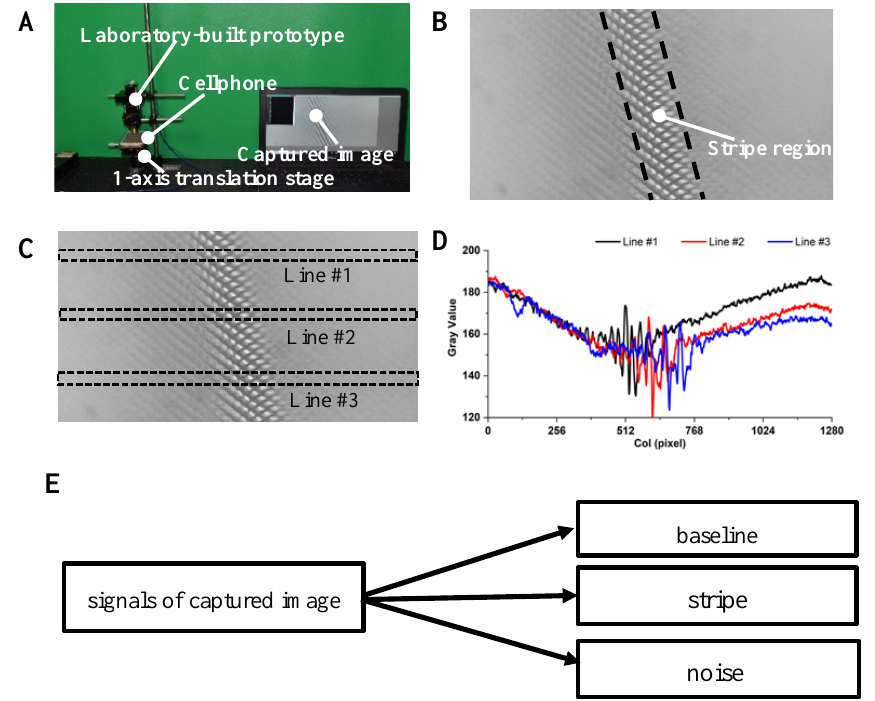
Figure 8. Functional test experiment. ( A ) Experiment setup including the laboratory-built prototype, a 1-axis translation stage and a cellphone. ( B ) Image captured by the laboratory-built prototype. ( C ) Dash line of the rectangular region is the selected region to be plotted. ( D ) The plotted profile of the selected region. ( E ) The captured image signal mainly consists of three components: baseline, stripe and noise.